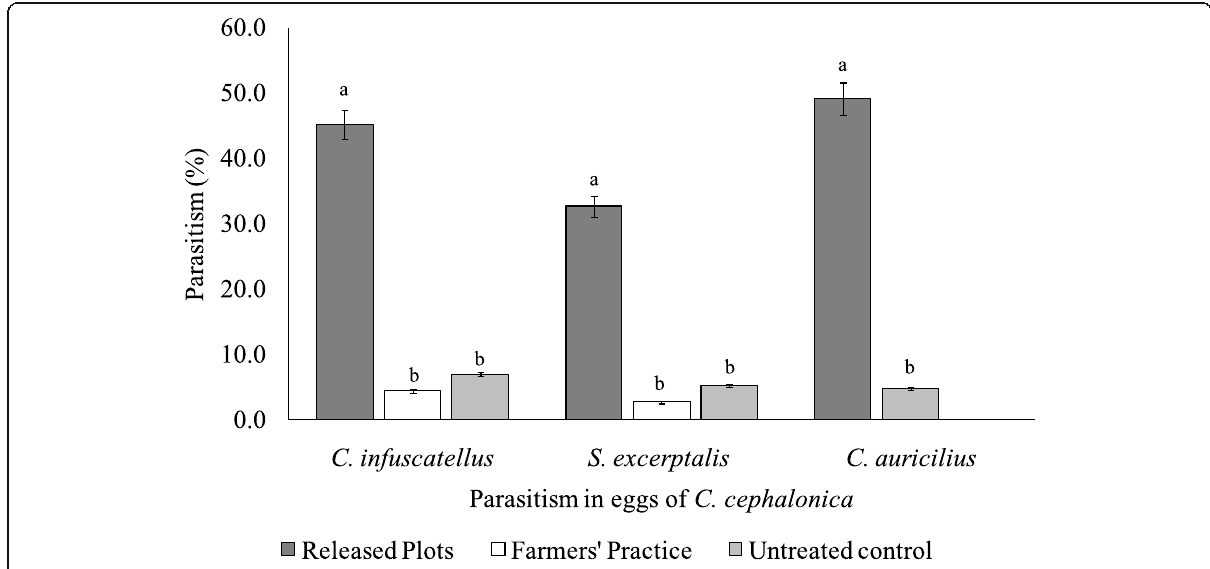
Fig. 3 Parasitism of C. cephalonica eggs in released fields wherein trichogrammatids were released against sugarcane borers (pooled mean of 5 years); values followed by different letters in the columns are significantly different at P = 0.05